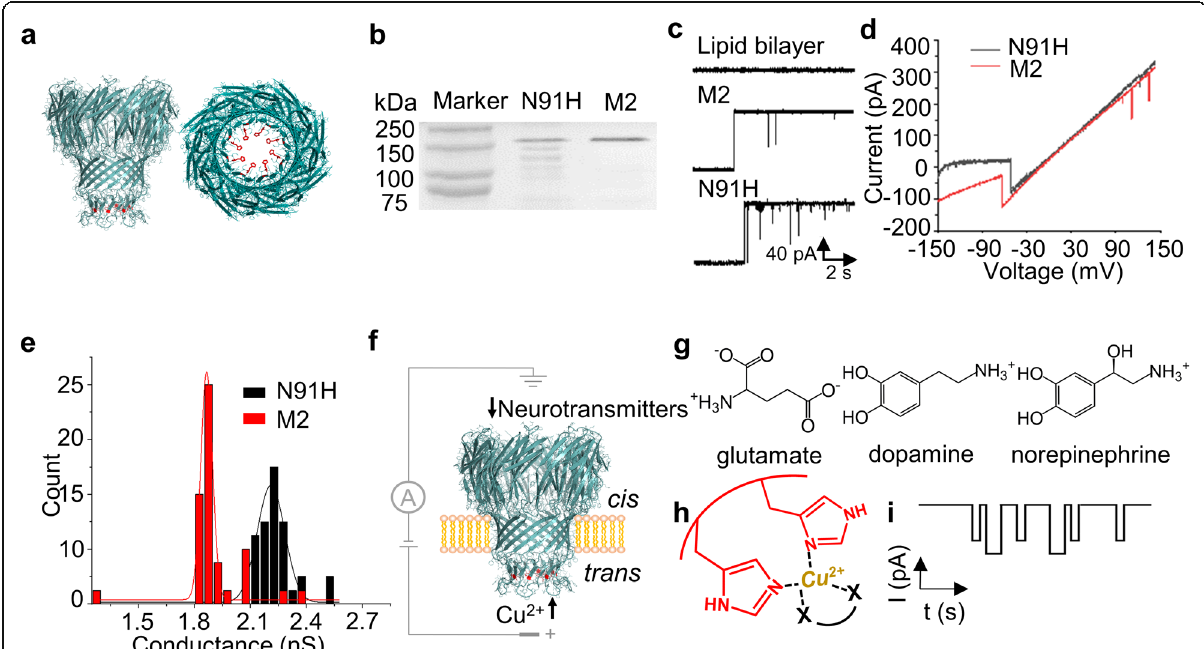
Fig. 1 Electrophysiological properties of the engineered M2MspA-N91H and scheme of neurotransmitters detection. a Side-view (left) and top- view (right) of M2MspA-N91H structure modeled by SWISS-MODEL. b SDS-PAGE analysis of M2MspA-N91H and M2MspA. N91H represents M2MspA-N91H, and M2 represents M2MspA. c Typical current traces of blank, M2MspA and M2MspA-N91H nanopore inserting into lipid bilayer in 1 M KCl, pH 7.5, 50 mV. d I-V curves of M2MspA-N91H and M2MspA at scanning potential from − 150 to 150 mV. e Conductance histograms of M2MspA-N91H and M2MspA nanopore inserting into lipid bilayer in 1 M KCl, pH 7.5 ( n = 35). f Experimental setup. The mutant protein M2MspA- N91H is incorporated into lipid bilayer from the cis (grounded) side of the setup. Cu 2+ and neurotransmitters are added to trans and cis side, respectively, which both move towards the constriction region of M2MspA-N91H under a positive potential. g Ionization structures of three neurotransmitters: glutamate, dopamine and norepinephrine. h The principle of detection of neurotransmitters. Cu 2+ non-covalently binds to the two nearby histidine residues at the constriction region of M2MspA-N91H firstly, then neurotransmitters which can interact with Cu 2+ are detected. i Idealized current signals caused by different kinds of neurotransmitters binding reversibly to the Cu 2+ -M2MspA-N91H